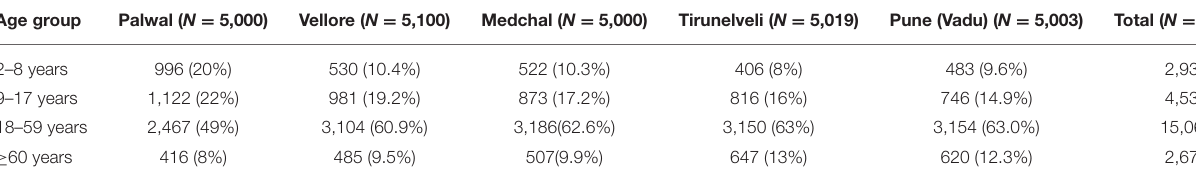
TABLE 1 | Site-wise age stratified recruitment completed at baseline.